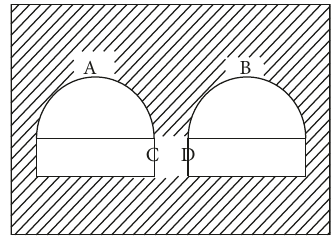
Figure 14: Layout of measuring points.